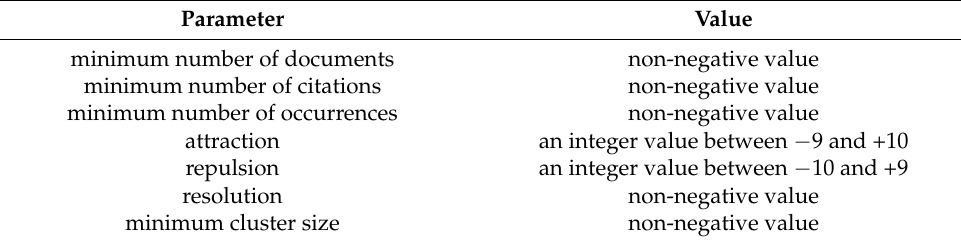
Table 1. Parameters used for the map in VOSviewer